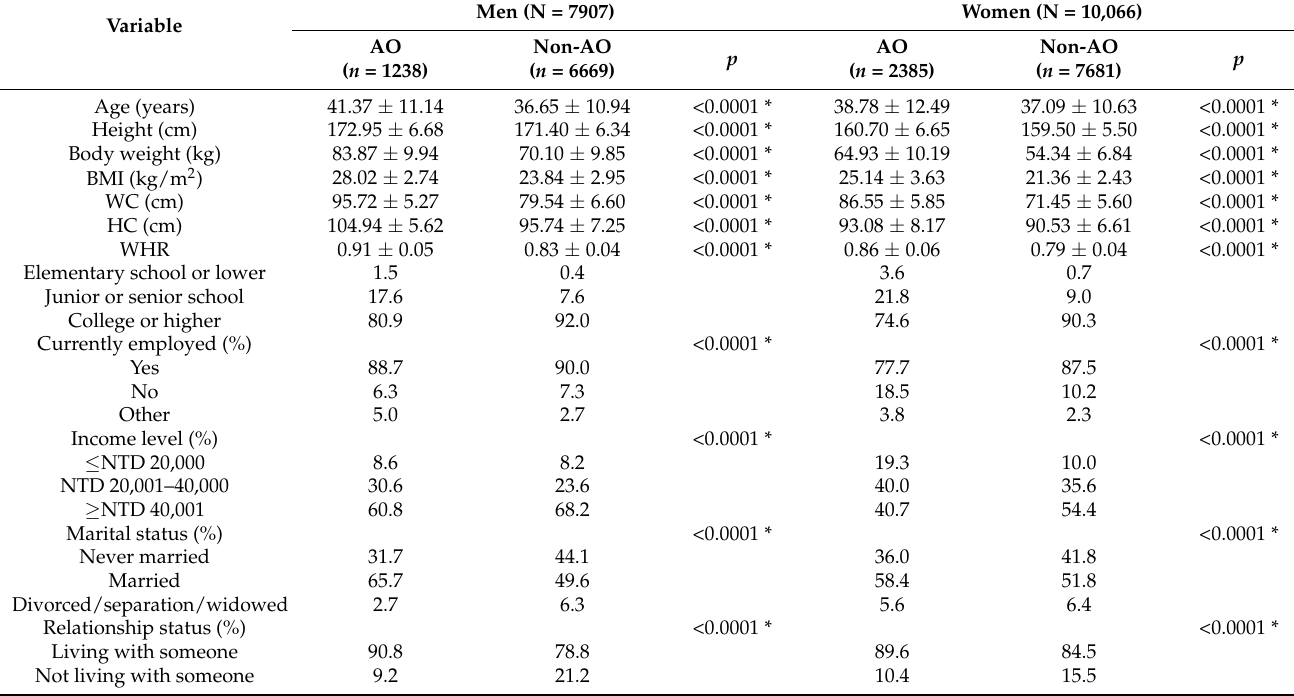
Table 1. Characteristics of the study participants, with or without abdominal